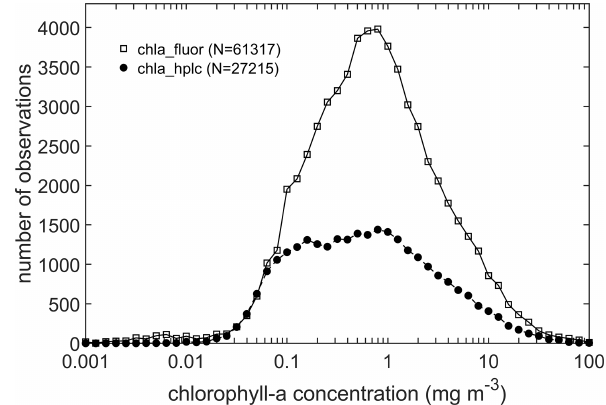
Figure 7. Number of observations per chlorophyll- a concentration acquired with different methods (“chla_fluor” and